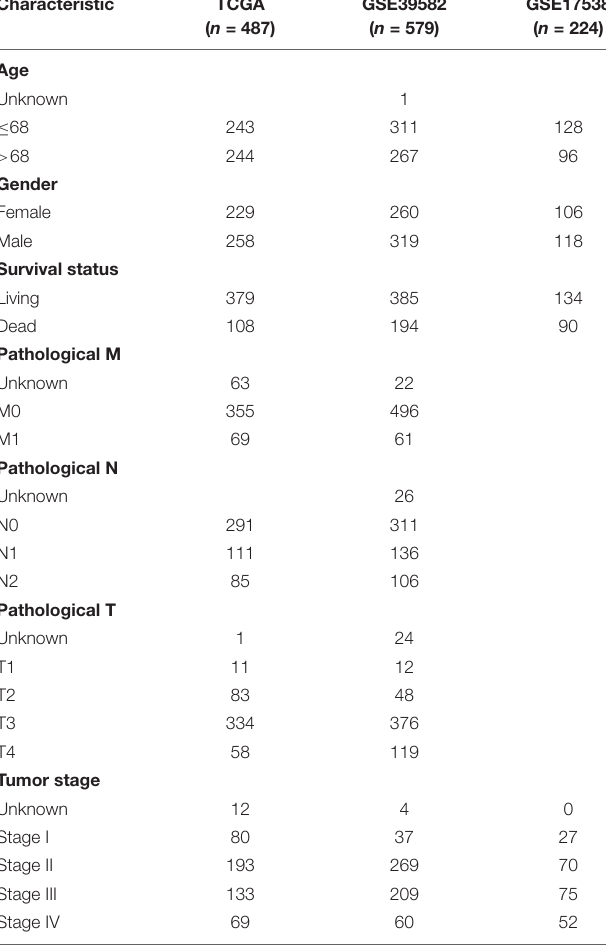
TABLE 1 | Clinical characteristics of the CRC